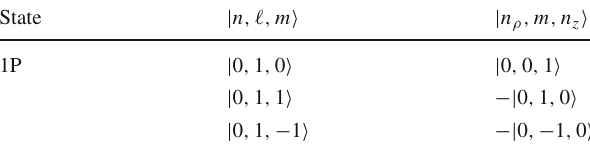
Table 10 The transformation of the 1P wave (states with n = 0 and (cid:16) = 1) from the spherical coordinate to the cylindrical coordinate State